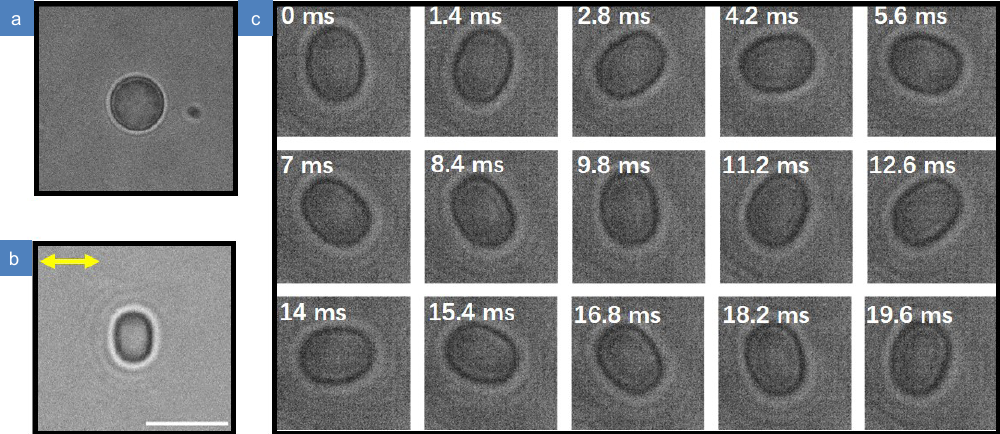
Fig. 4 | Video snapshots of disc-shaped vaterite particles recorded by optical tweezer apparatus. ( a ) Top view of a vaterite particles before being trapped. Note that the optical axis is perpendicular to the top facet. ( b ) Top view of the vaterite particles after being trapped by the linear polarized beam with the polarization angle indicated by the yellow arrow. ( c ) Video images recorded every 1.4 ms for a 1.5 μ m diameter and 1 μ m thickness vaterite micro-disc being rotated clockwise in the optical trap (Supplementary Video 2).